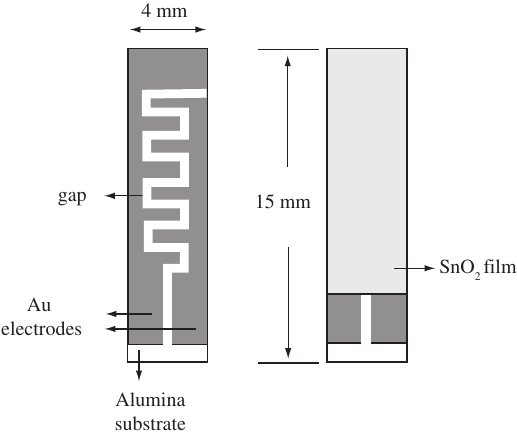
Figure 1. Schematic drawing showing the geometry and dimensions for the sputtered and doctor-bladed samples.